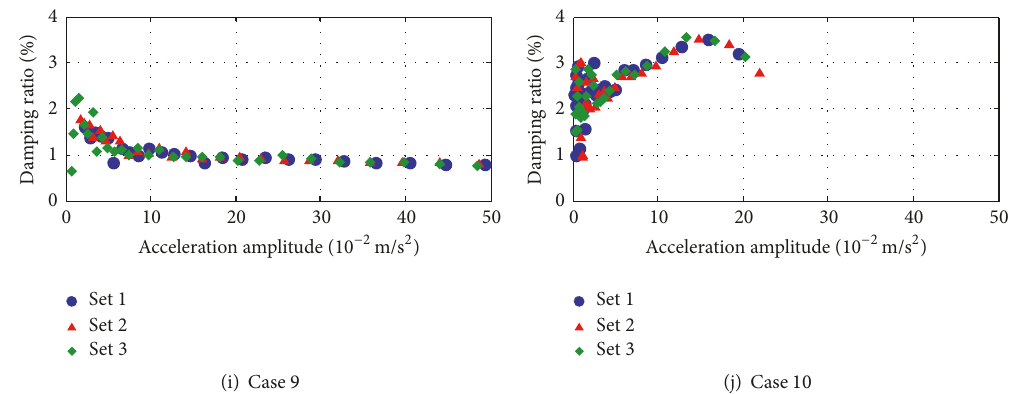
Figure 12: Amplitude-dependent damping ratios estimated from free vibration tests.